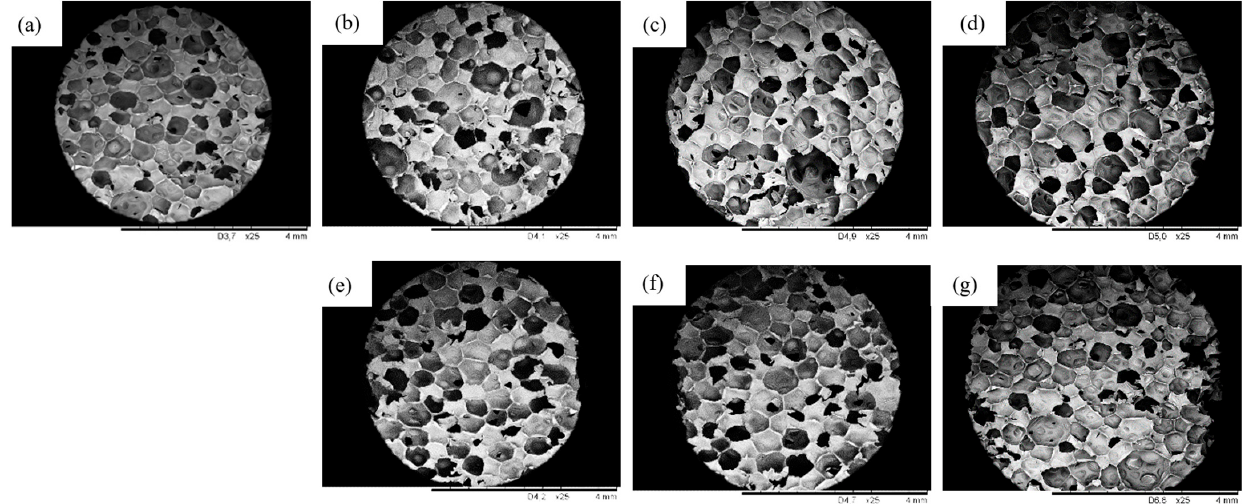
Figure 5. Cellular morphology of ( a ) PUR_REF, ( b – d ) PUR_P, and ( e – g ) PUR_Si-P.